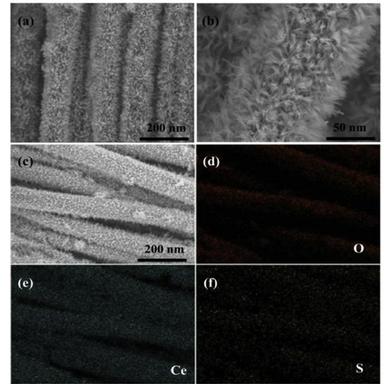
(a) and (b) SEM images of the feather duster liked CeO2 nanofibers. (c) SEM image of FDCO/S composites. (d), (e) and (f) Corresponding elemental mapping of O, Ce and S for the FDCO/S composites.